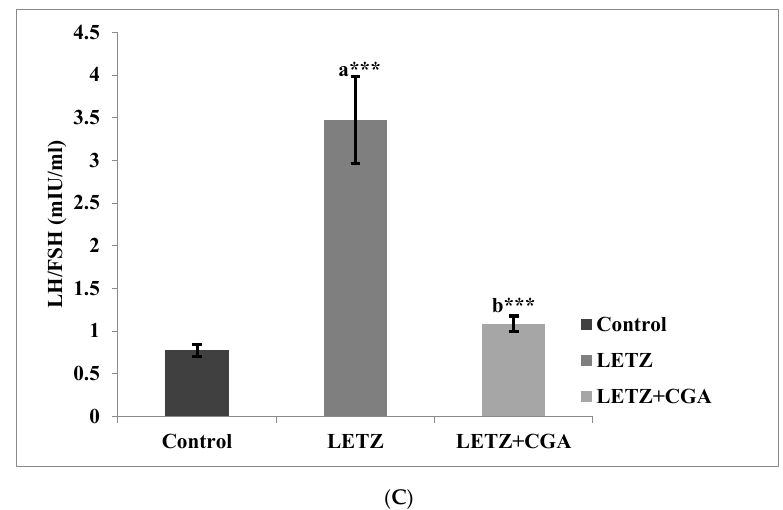
Figure 2. ( A ) Effect of CGA on serum testosterone and FSH levels in mice with PCOS. Control: normal saline; PCOS: letrozole (6 mg/kg); PCOS with CGA: (LETZ at 6 mg/kg and CGA at 50 mg/kg); a = PCOS versus control; b= PCOS versus PCOS with CGA. With n = 6 per group, all values are expressed as means with standard errors. *** p < 0.001; CGA = chlorogenic acid. ( B ) Effect of CGA on serum estrogen and LH levels in mice with PCOS. Control: normal saline; PCOS: letrozole (6 mg/kg); PCOS with CGA: LETZ at 6 mg/kg and CGA at 50 mg/kg; a = LETZ versus control; b = LETZ versus LETZ with CGA. With n = 6 per group, all values are expressed as means with standard errors. *** p < 0.001; ** p < 0.01; CGA = chlorogenic acid. ( C ). Effect of CGA on serum LH and FSH ratio levels in mice with PCOS. Control: normal saline; PCOS: letrozole (6 mg/kg); PCOS with CGA: LETZ at 6 mg/kg and CGA at 50 mg/kg; a = LETZ versus control; b = LETZ versus LETZ with CGA. With n = 6 per group, all values are expressed as means with standard errors. *** p < 0.001; ** p < 0.01; CGA = chlorogenic acid; LETZ = letrozole.